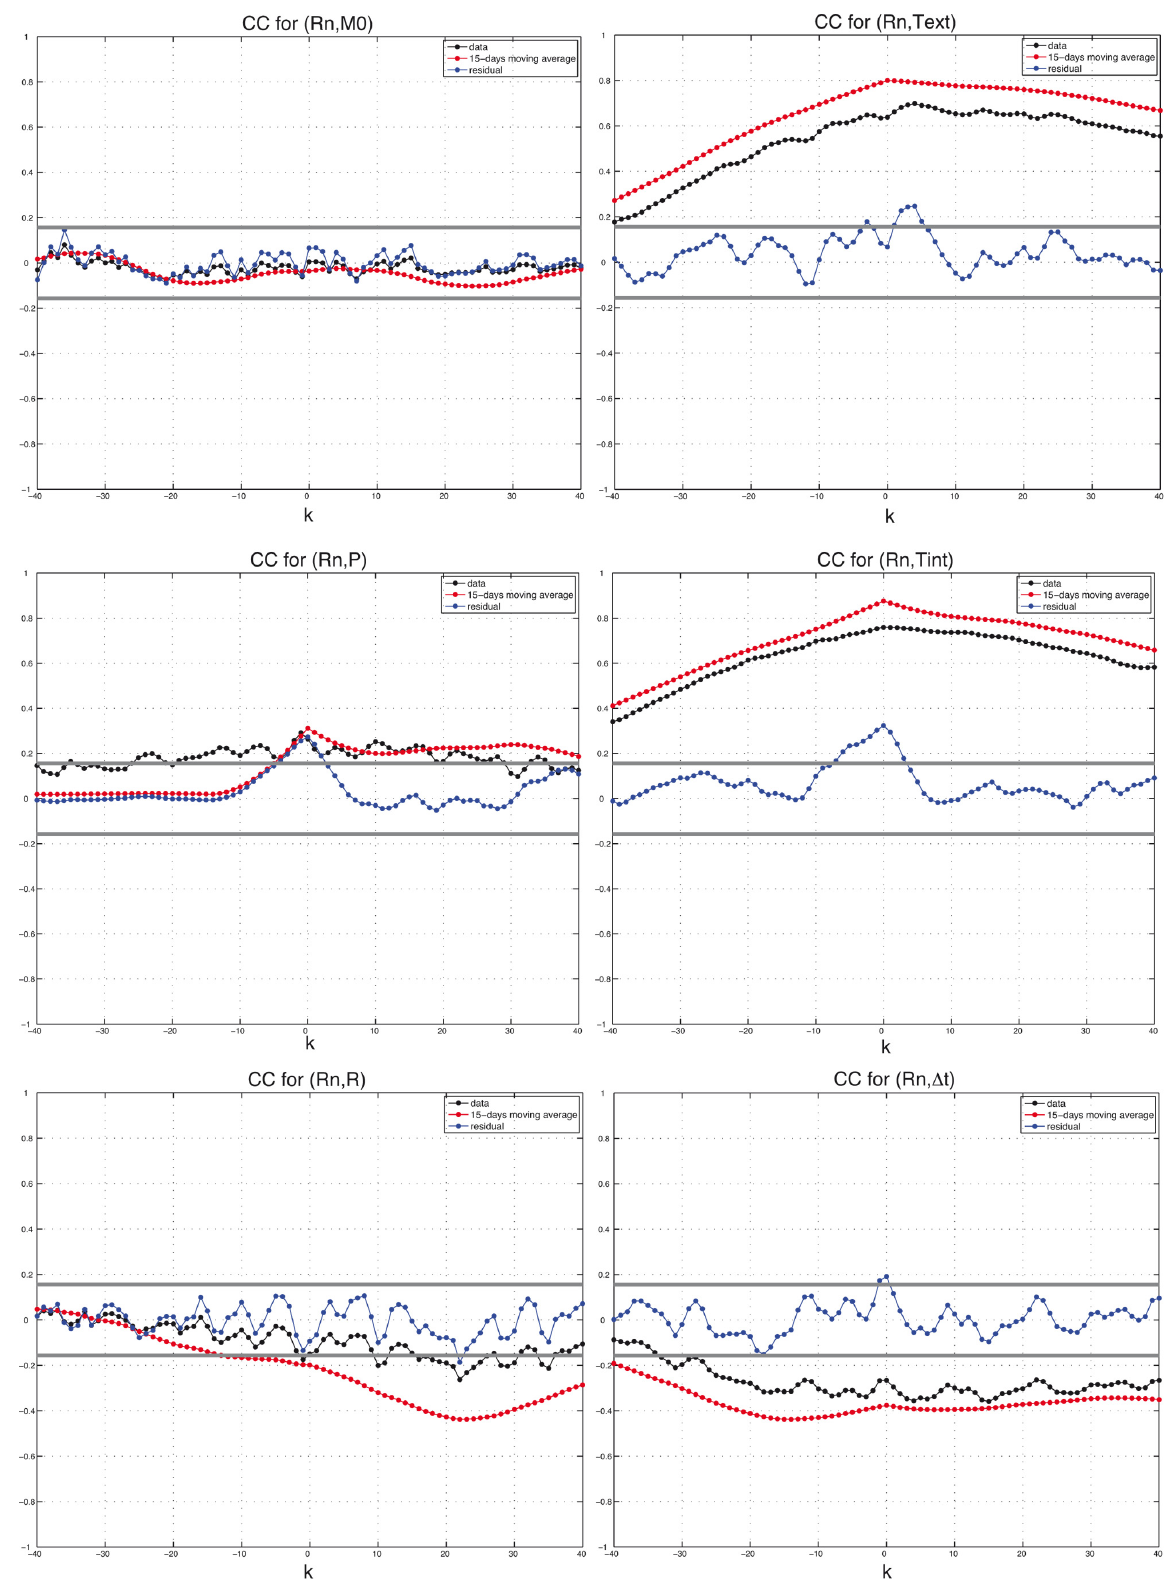
Figure 10. The same as in Figure 8, but for the segment January 1, 2013 - December 31,